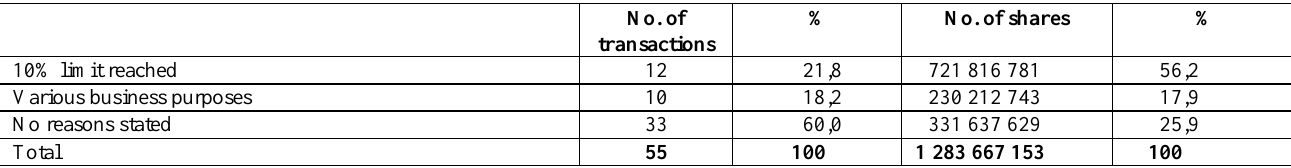
Table 4: Motivations for the repurchase of treasury shares from subsidiaries